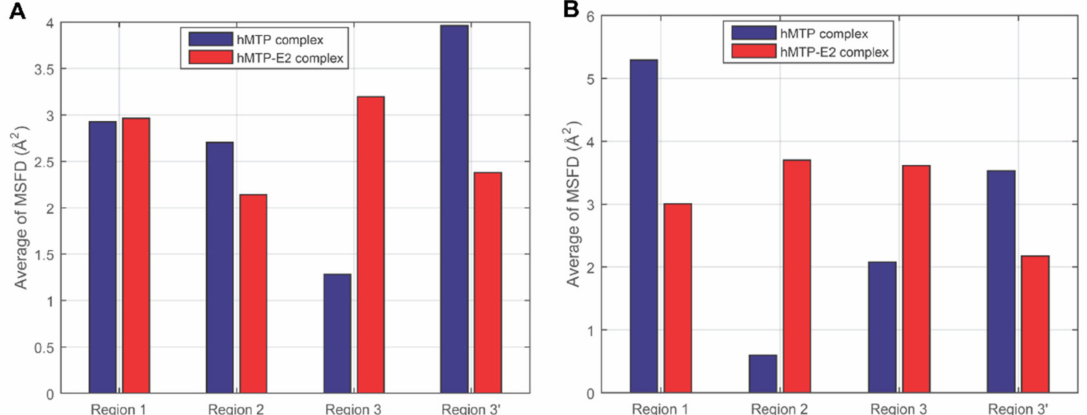
Figure 4. Average of mean square fluctuation of distance (MSFD) of the interface contacts during the production simulation process. ( A ) Average of MSFDs in the four interface regions of hMTP and hMTP–E 2 complexes with a hydrogen bond constraint in the simulation process. ( B ) Average of MSFDs in the four interface regions of hMTP and hMTP–E 2 complexes without the hydrogen bond constraint in the simulation